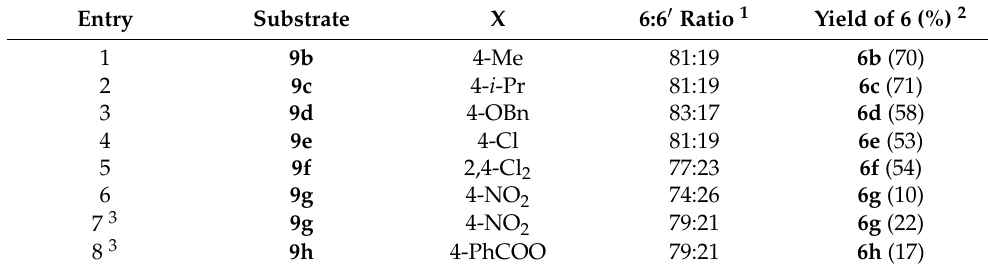
Table 2. Ball-milling (3 + 2)-cycloadditions of 9b – 9h with model chalcone ( 10a ).